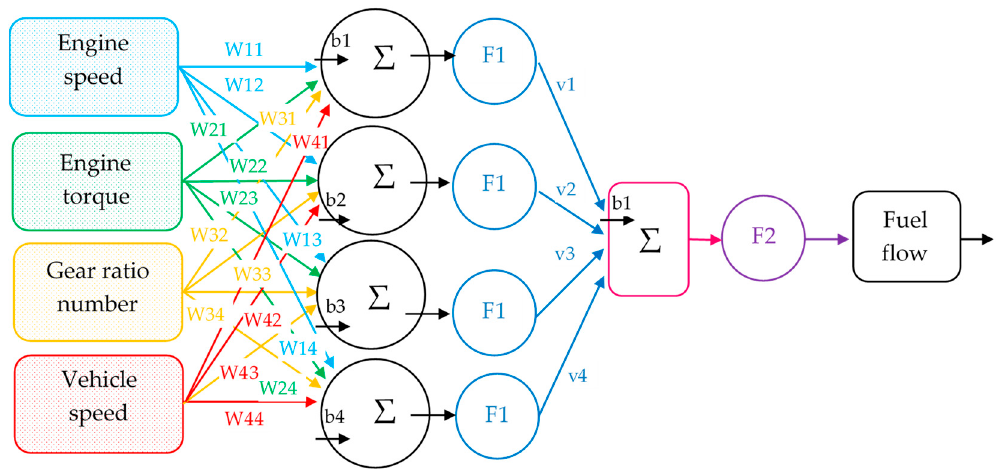
Figure 2. A general scheme of the structure of the neural network applied [187,188].